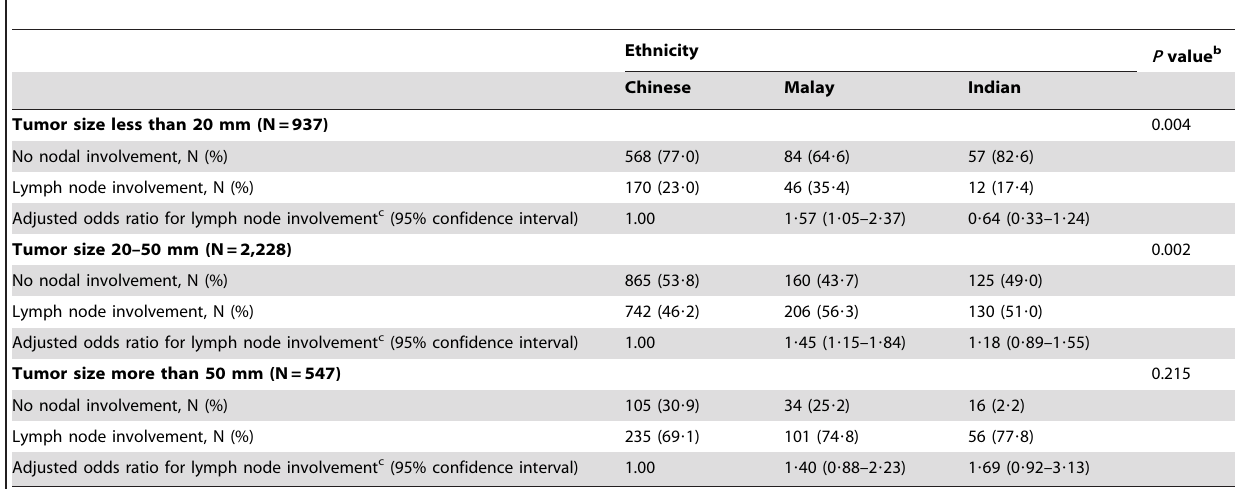
Table 3. Association between ethnic groups and lymph node involvement by tumor size in 3,712 Asian women with breast cancer.